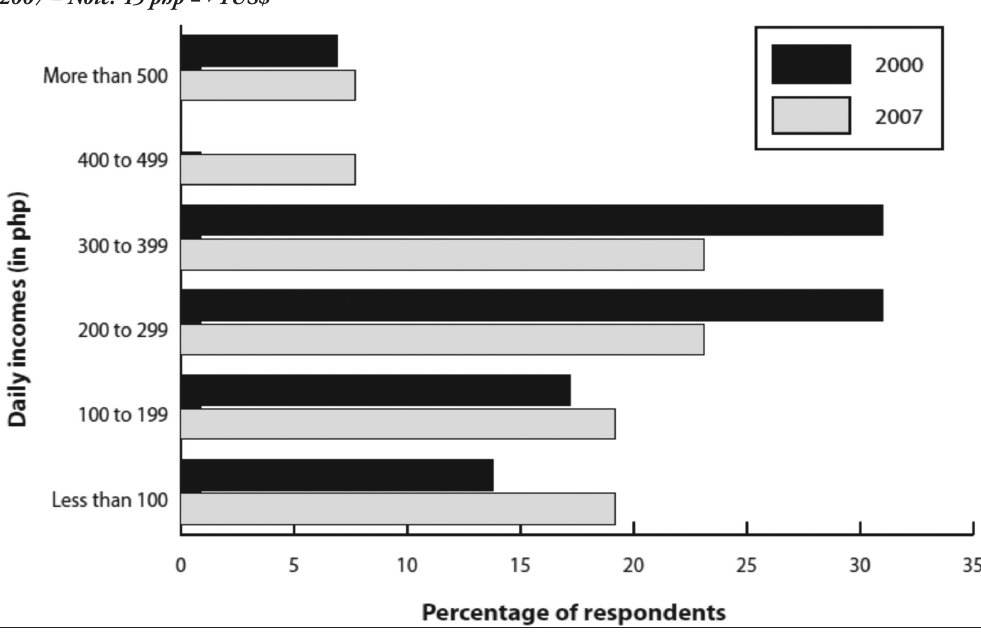
From marginality to further marginalization: Experiences from the victims of the July 2000 Fig 4. Daily incomes of surveyed households affected by the July 2000 trashslide in Payatas - n=30 in 2000 and 2007 – Note: 45 php = ~1US$